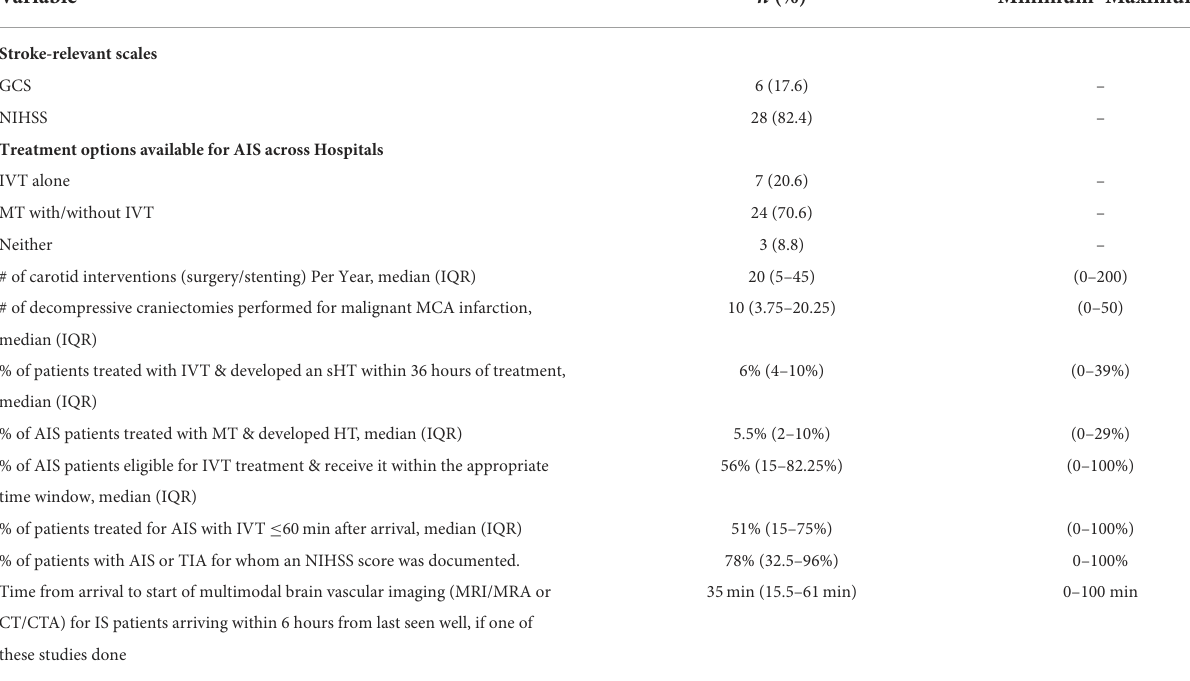
TABLE 3 Treatment options delivered for